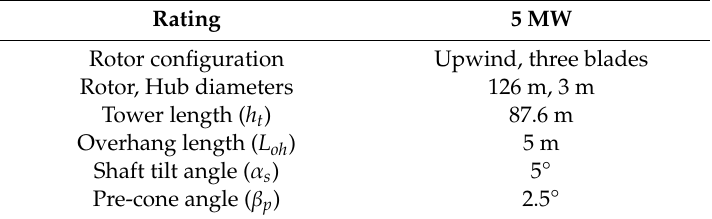
Table 1. Gross properties of NREL 5 MW reference wind turbine (Reproduced from [14], NREL: